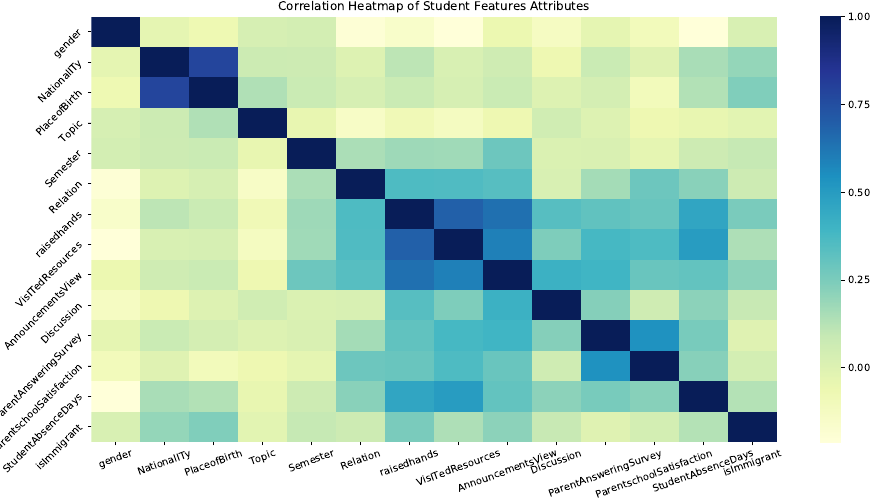
Figure 7. Heatmap of student features attributes.